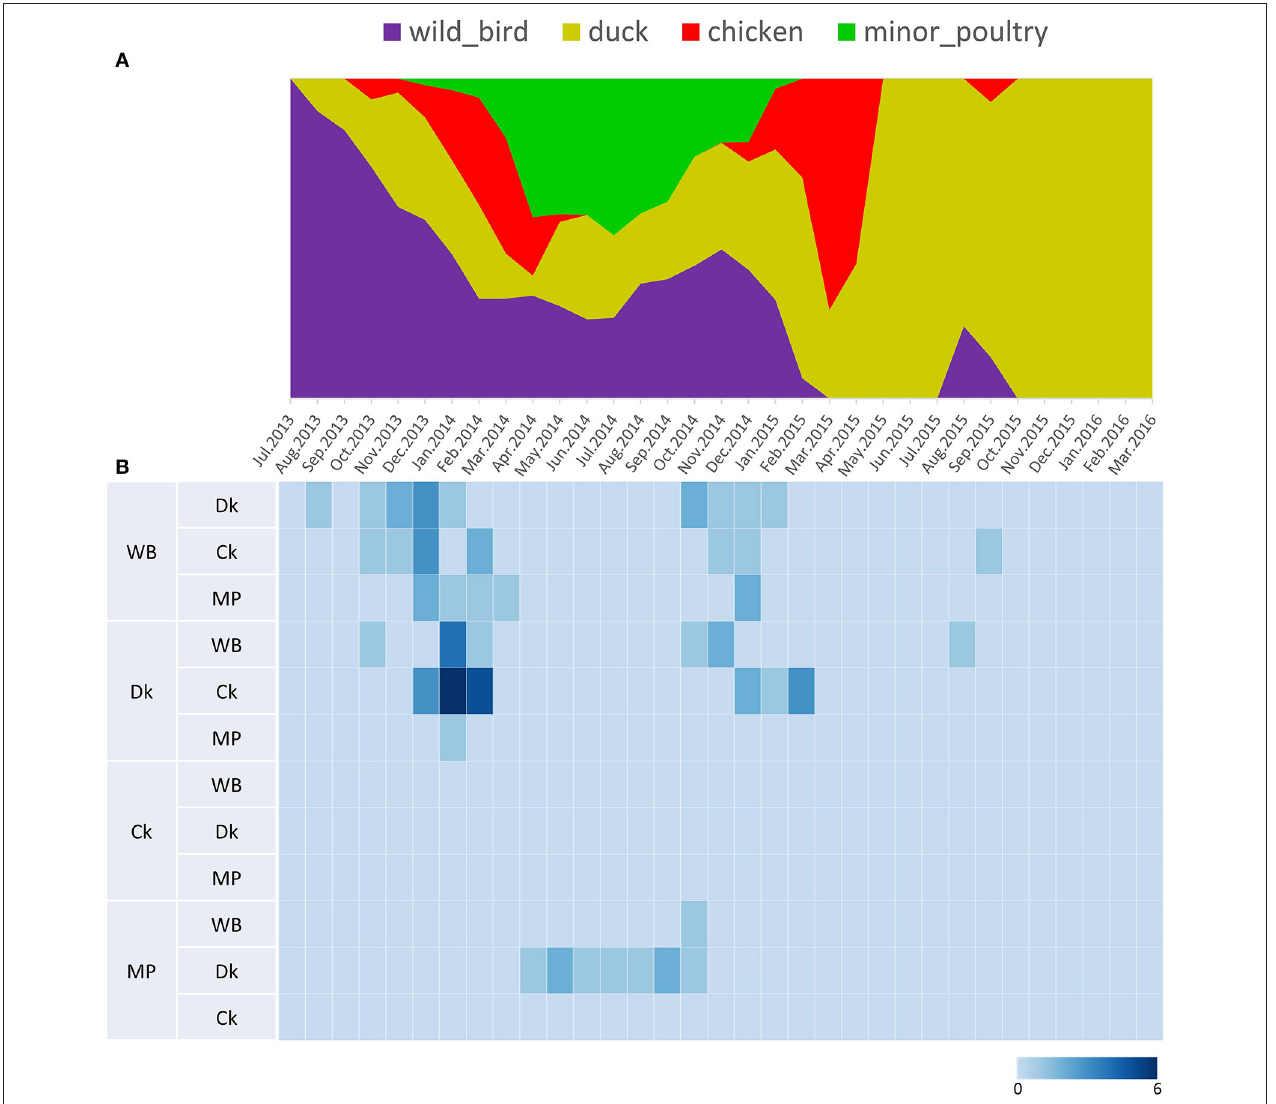
FIGURE 5 | Transition events and discrete state proportion over time of H5N8 high pathogenicity avian influenza viruses isolated in South Korea during 2014–2016. (A) Proportion of ancestral discrete states estimated on the phylogenetic trunk of H5N8 viruses over time. The host species were defined as discrete states. Shaded areas represent estimated ancestral discrete state proportions of each state. At each point in time, the width (y-axis) represents the mean proportion from 0 to 100% of each state. (B) Heat map showing the number of transition events between each discrete state (0–6) over